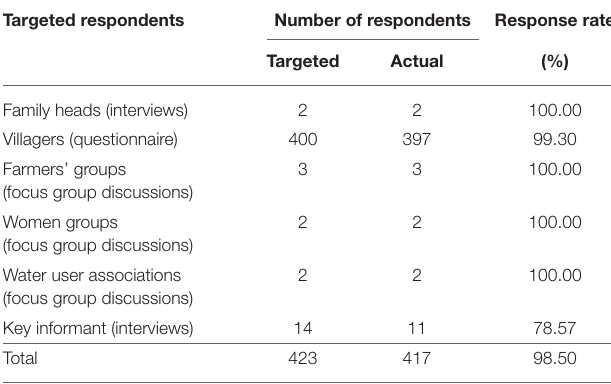
TABLE 1 | Sampling distribution of the respondents in the survey. Zone